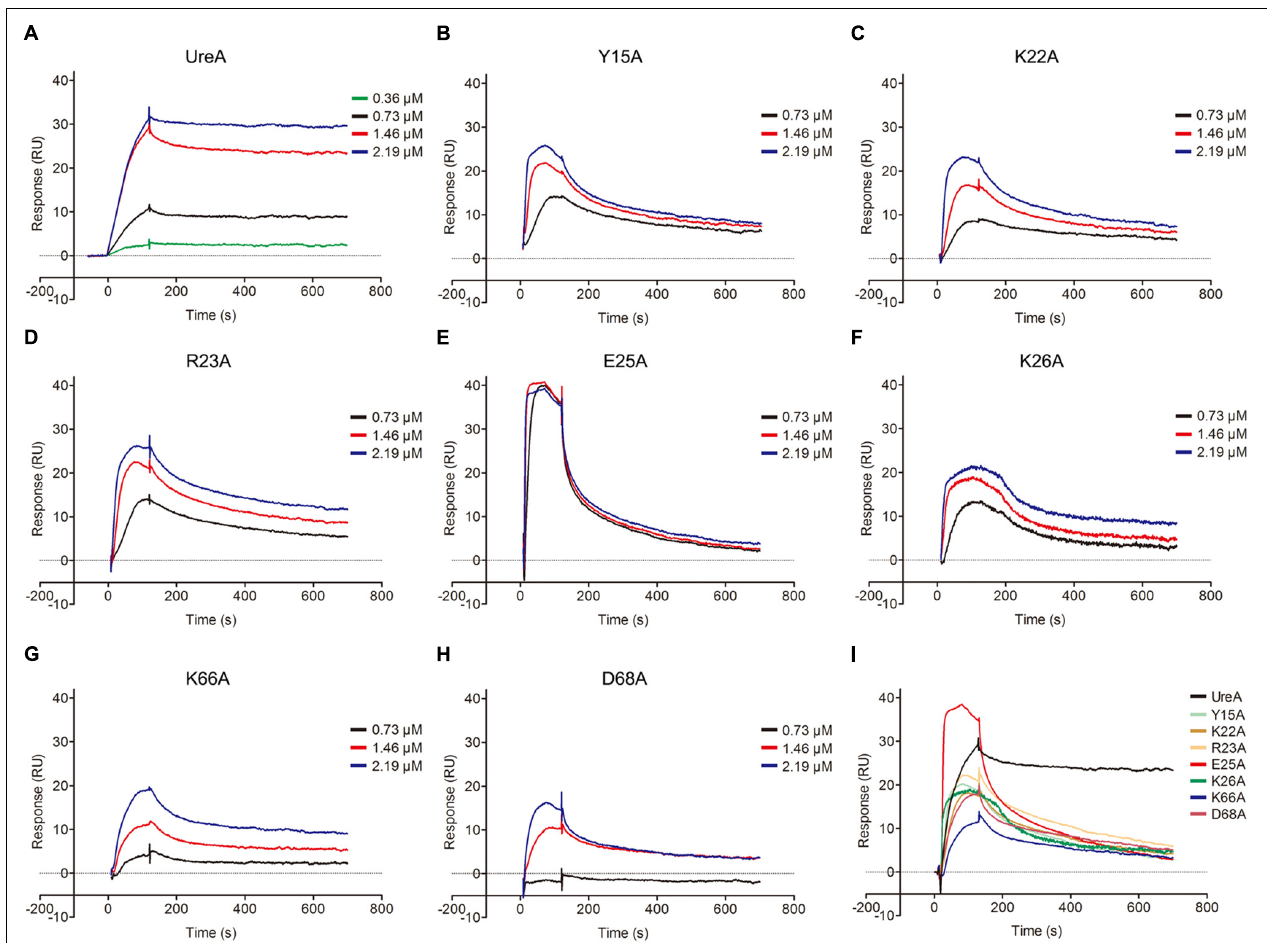
FIGURE 6 | Sensorgram data of UreA-His and its mutants binding to Hsp60. (A–H) Wild-type UreA-His or its mutants with a series of concentrations (0.36, 0.73, 1.46, and 2.19 µ M) were injected over a control surface (no Hsp60) and a surface containing ∼ 600 RU of Hsp60 for 120 s with the dissociation monitored for 800 s. Then, the analyte was removed by injecting 45 µ l of 5 mM NaOH in 90 s to regenerate the surface. For the mutants, only three protein concentrations (0.73, 1.46, 2.19 µ M) were retained in the graph. (I) Integrated sensorgram data of UreA-His and its seven mutants binding to Hsp60 with a concentration of 40 µ g/ml (1.46 µ M). All experiments were repeated at least three